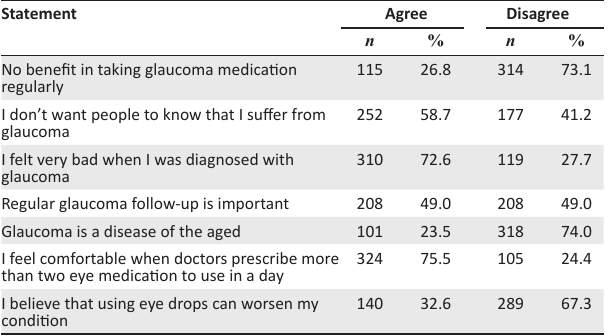
TABLE 2: Attitude and beliefs towards glaucoma disease.